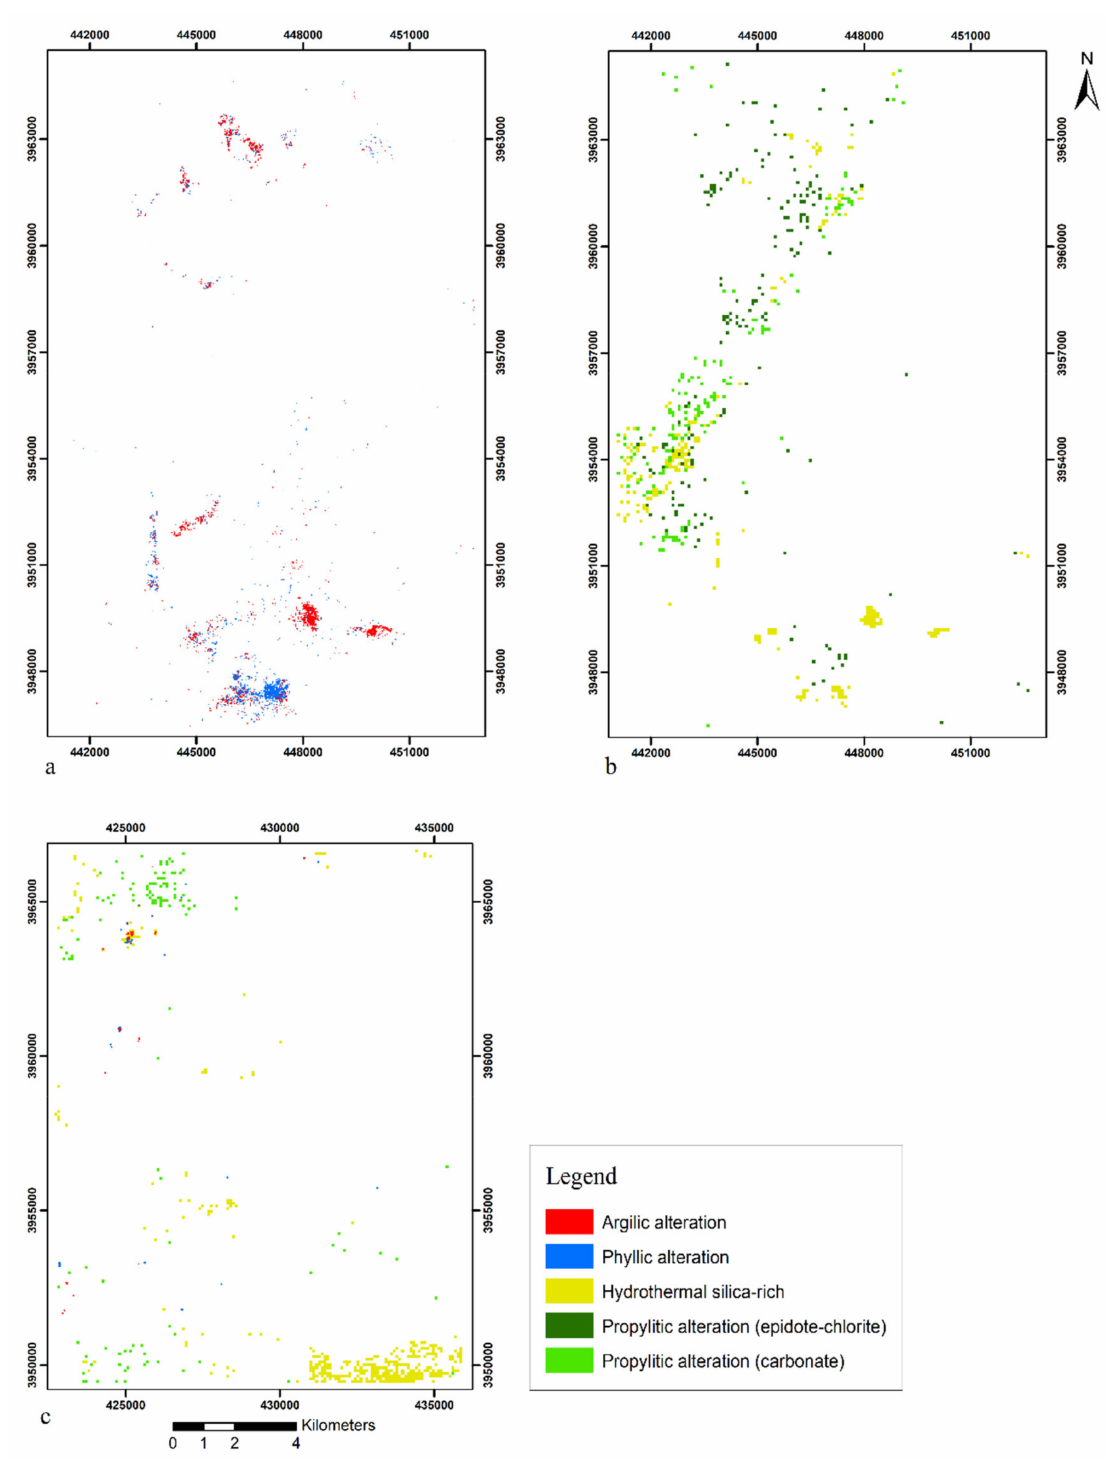
Figure 11. Hydrothermal alteration obtained from ASTER using logical operator algorithms. ( a ) Argillic and phyllic alteration in zone I; ( b ) hydrothermal silica-rich, propylitic alteration (car- bonate), and propylitic alteration (epidote-chlorite) in zone I; ( c ) argillic, phyllic, and